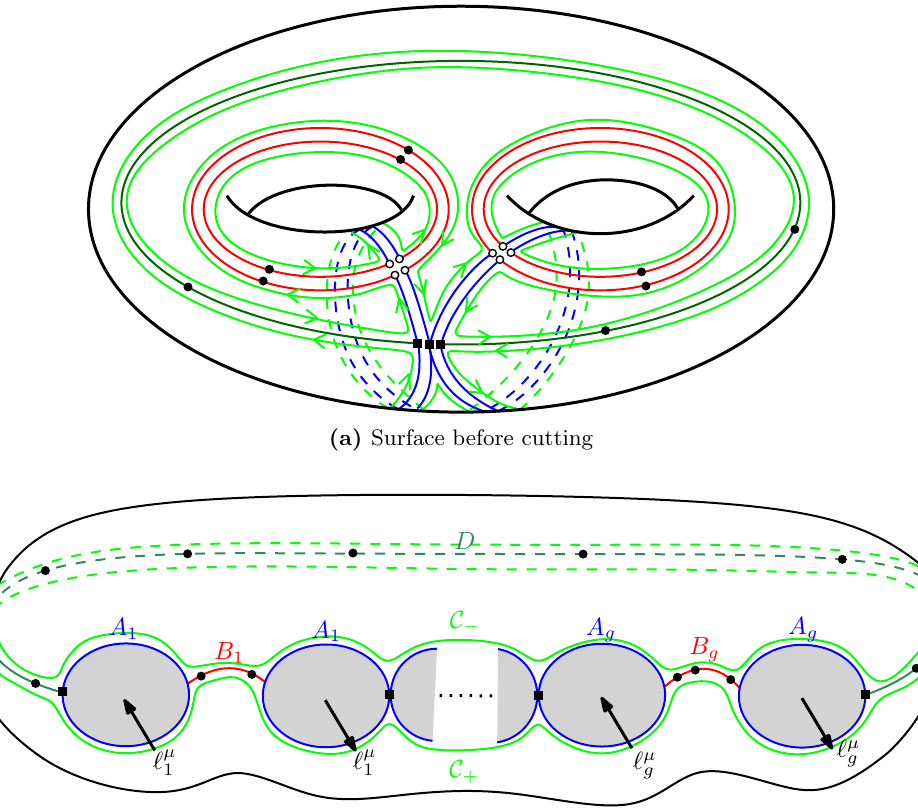
Figure 1. Genus- g Riemann surface sliced along the A I -cycles (blue). Loop momenta ‘ (cid:22) through the two pairs of resulting disks for each I = 1 ; 2 ; : : : ; g (the point denoted with a black box is identi(cid:12)ed). The resulting Riemann surface can be understood as two copies of open-string worldsheets glued together along B I -cycles (red) and D (dark green), on which punctures are placed. Monodromy relations are a consequence of the fact that the contours C (cid:6) (light green) can each be contracted to a